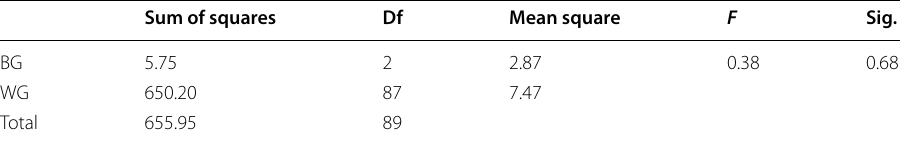
Table 7 Inferential statistics of speaking accuracy pretest of all groups Sum of